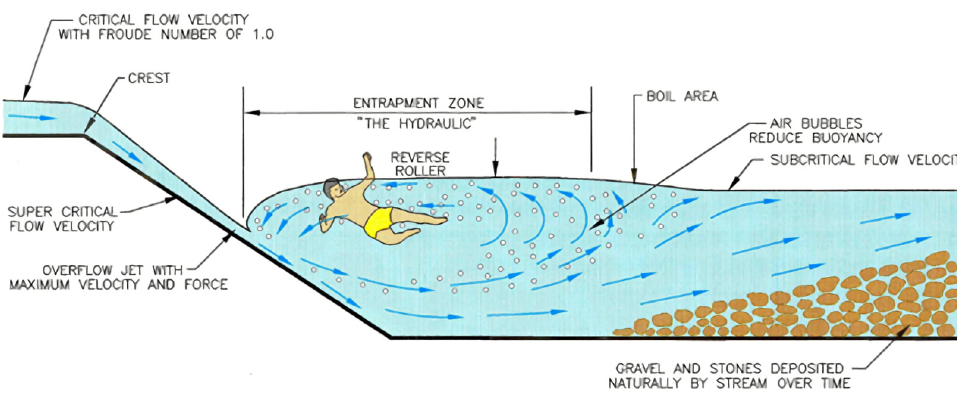
Figure 2. Elevation view of a submerged hydraulic jump at a low head dam (Reprinted with permission from Wright et al. [7] published by the Association of State Dam Safety Officials, 1995).